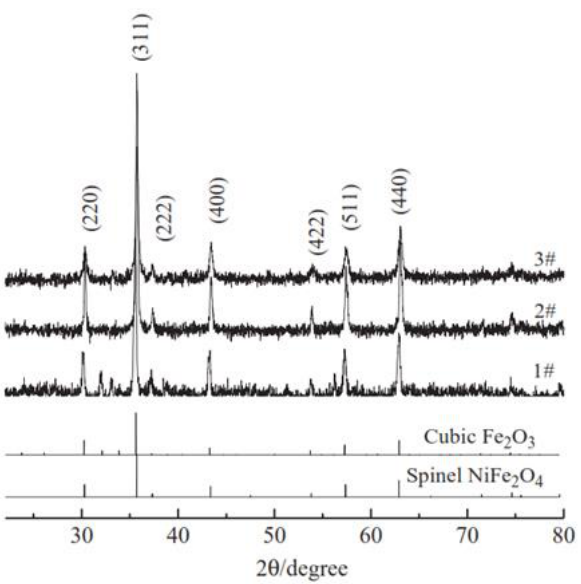
Figure 5. XRD patterns of the three samples synthesized, sample 1 (#1), sample 2 (#2) and sample 3 (#3). Reprinted with permission from Ref. [79]. Copyright 2014 Elsevier.